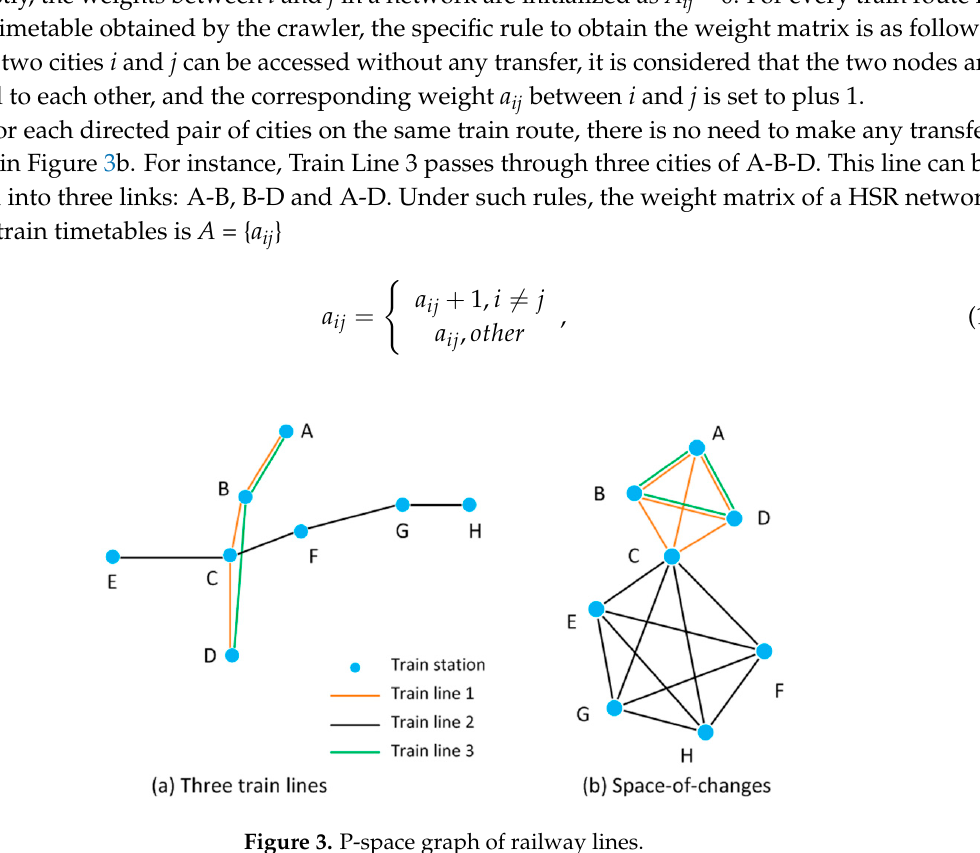
Figure 3. P-space graph of railway lines.